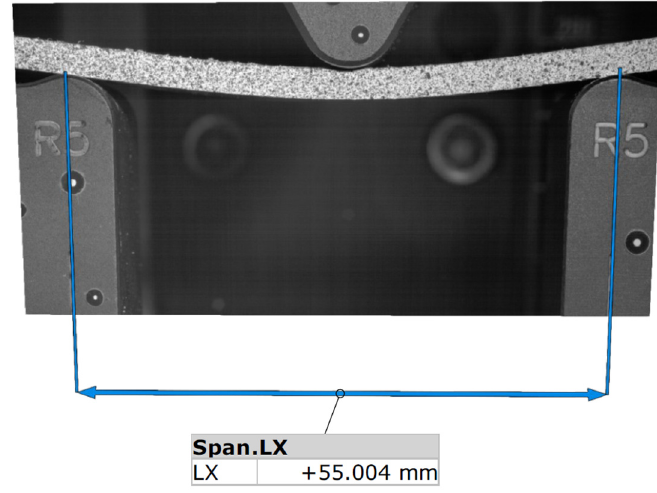
Figure 2. The measuring plan setup with span length.